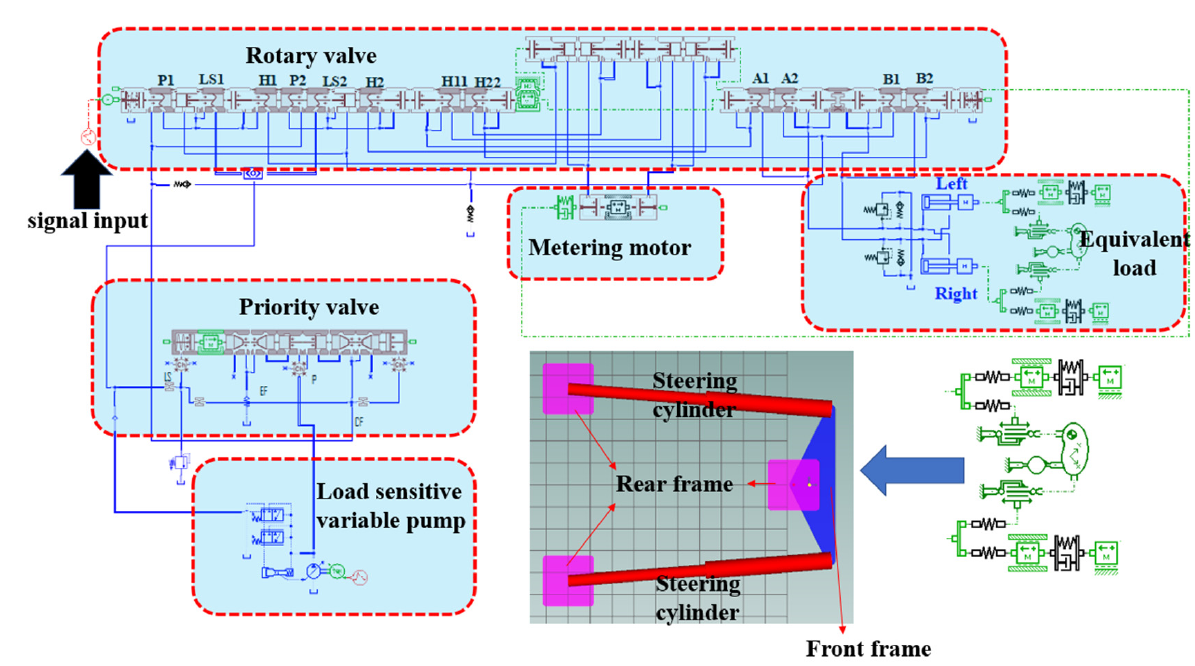
Figure 6. AMESim model of loader steering system.